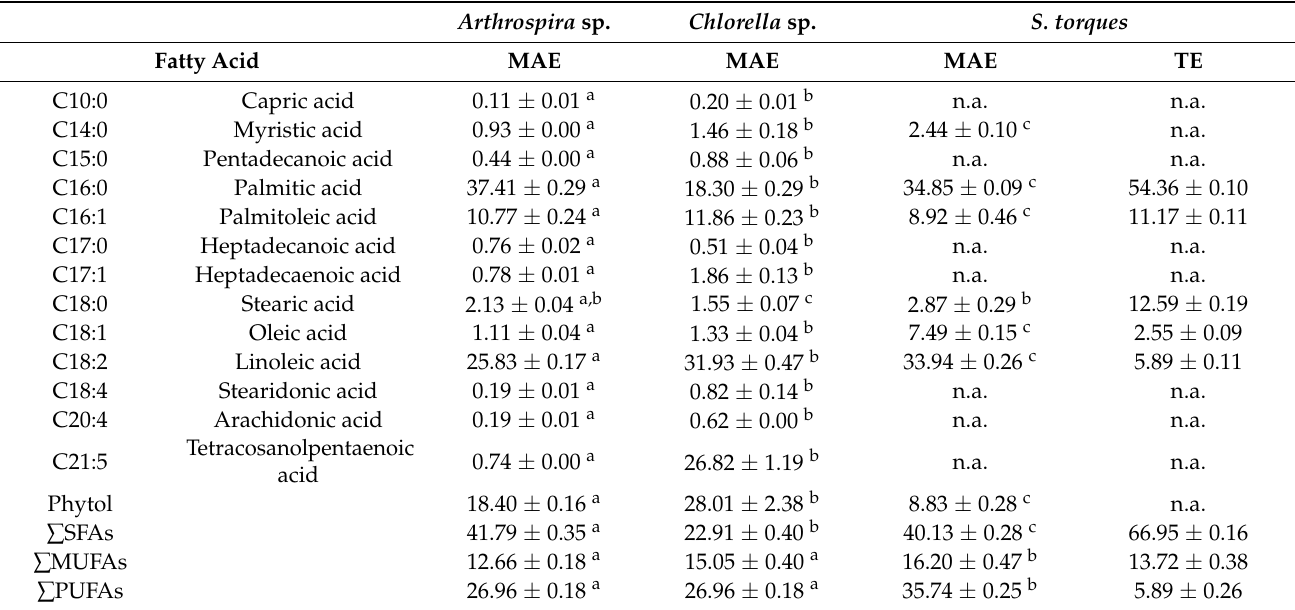
Table 1. Average composition (% of area) of fatty acids obtained by traditional and microwave- assisted extractions of cyanobacterial and microalgal biomass (n = 3). Arthrospira sp. Chlorella sp. S. torques